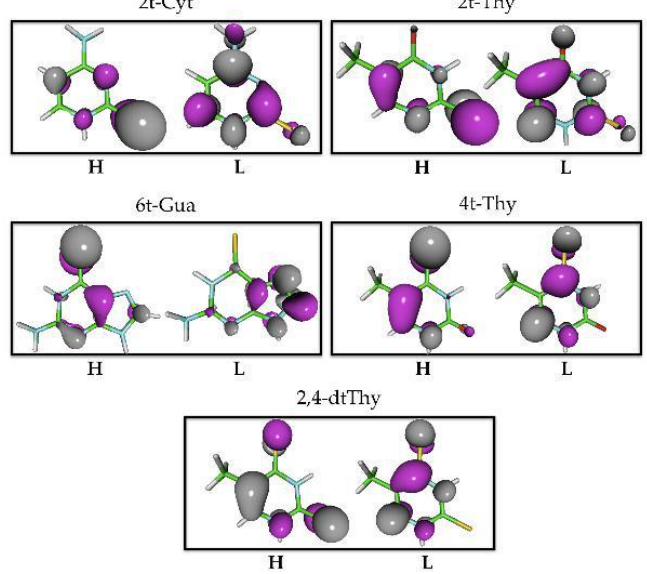
Figure 1. HOMO (H) and LUMO (L) molecular orbitals involved in the ππ* lowest